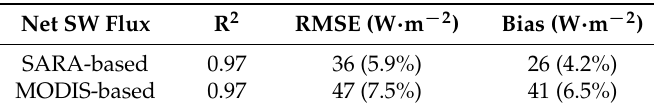
Table 4. Validation statistics for the SARA- and MODIS-based net surface SW radiative fluxes at the SGP sites in 2014 a .